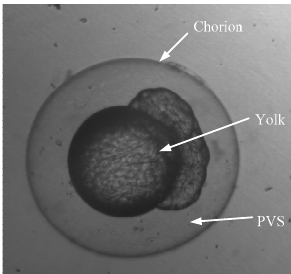
Figure 11. Structure of zebrafish embryo.